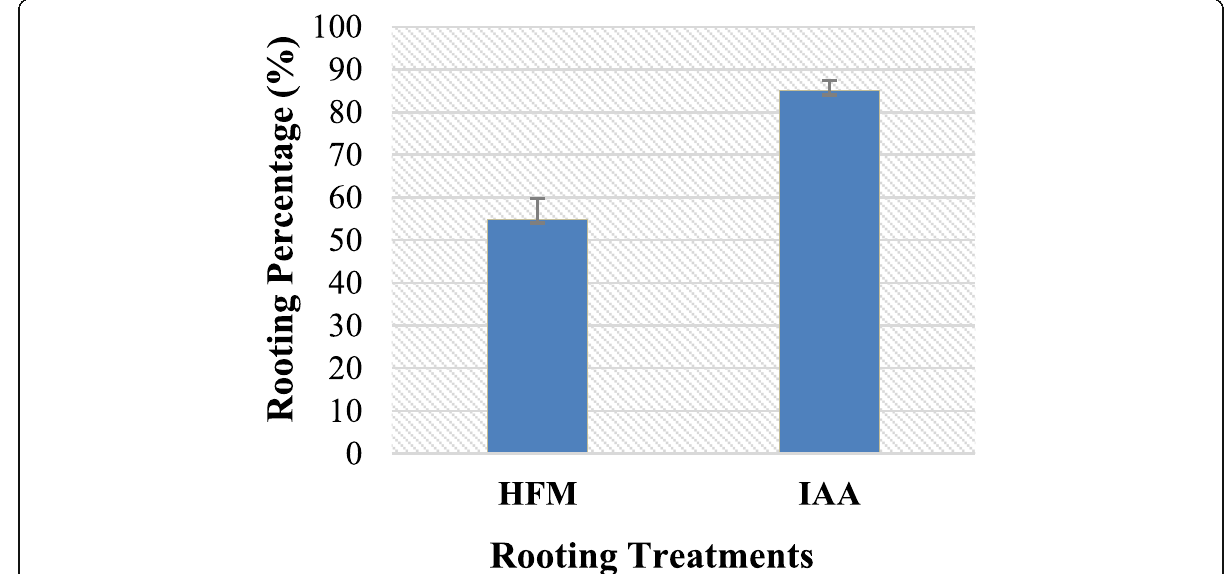
Fig. 4 Adventitious rooting percentage on MS-B 5 hormone free medium = HFM; MS-B 5 with 0.1 IAA mg/L =